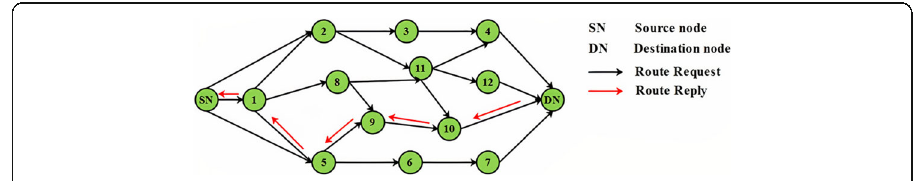
Fig. 9 AODV routing protocols-data